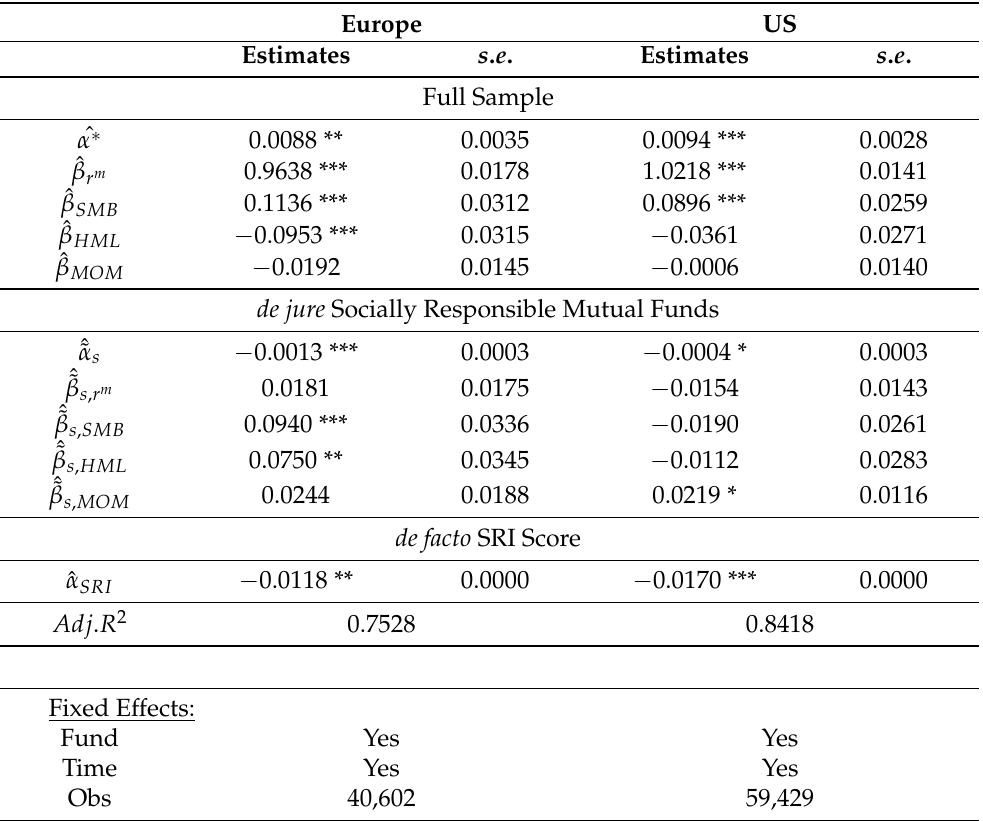
Table 7. Estimation of the augmented nonlinear panel version of Carhart’s model